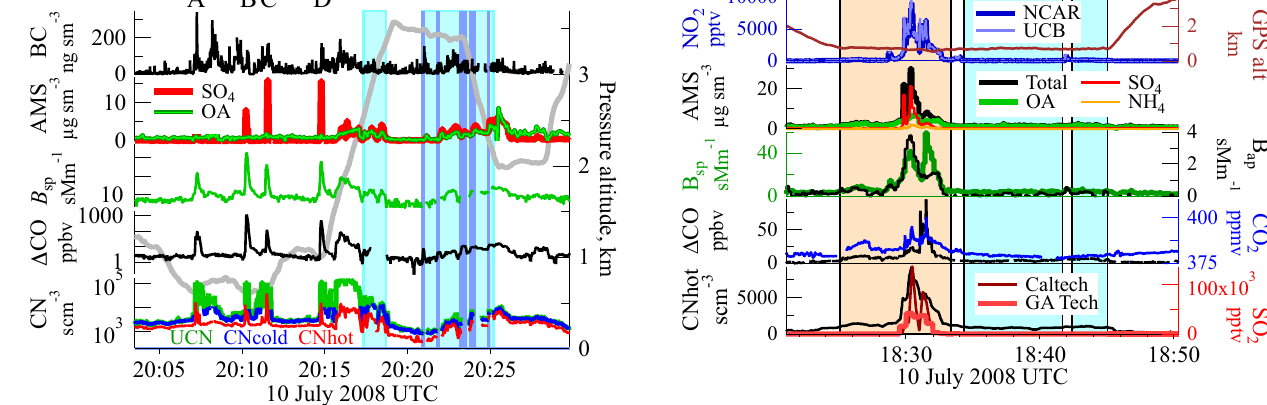
Figure 4. Data along the P-3B flight track shown in Fig. 1. Syn- crude upgrader plume penetrations occurred at points A, B, and D, while the Suncor plume was encountered at point C. Light-blue re- gions indicate periods when the plane was among clouds; darker blue shows cloud penetrations. Note that the UCN and CN saturate at 1 × 10 5 cm − 3 and 3 × 10 4 cm − 3 , respectively; actual values are higher than shown. The AMS was on a 5s cycle, blanking half the time, so it may have missed peak concentrations. CN, CO, and scat- tering ( B sp ) are on log scales; CO has the minimum concentration of 93.6 subtracted. The light-blue background shows periods among clouds; darker blue indicates cloud penetrations. Light scattering, B sp , is at 550nm.